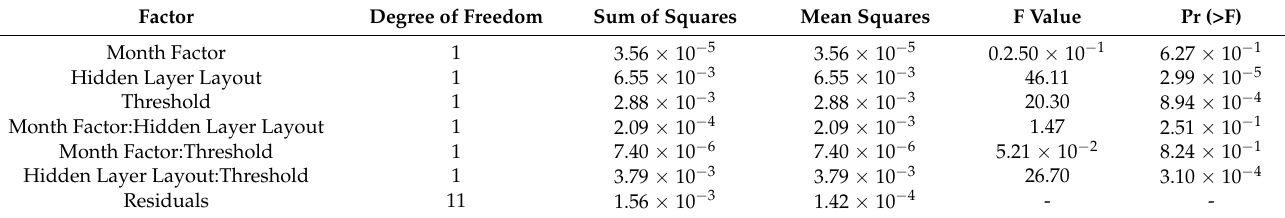
Table 11. R-squared and absolute errors in n σ of administrative district model with/without accu- rate weather forecasting (month: included, hidden layer layout: 12 × 12, threshold: 0.05). Without Accurate Weather Forecasting